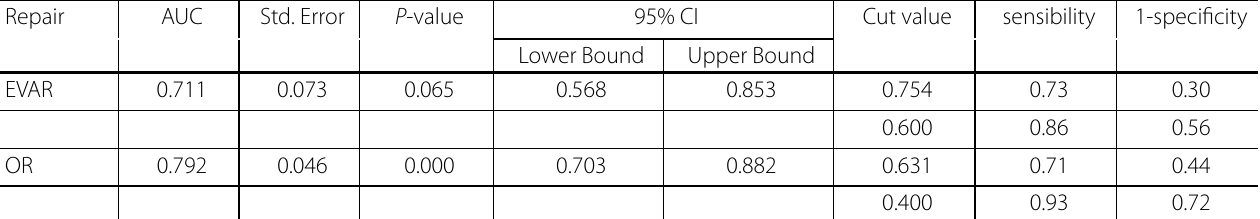
Table 4 . ROC curve discriminating values of PRS versus survival. Repair